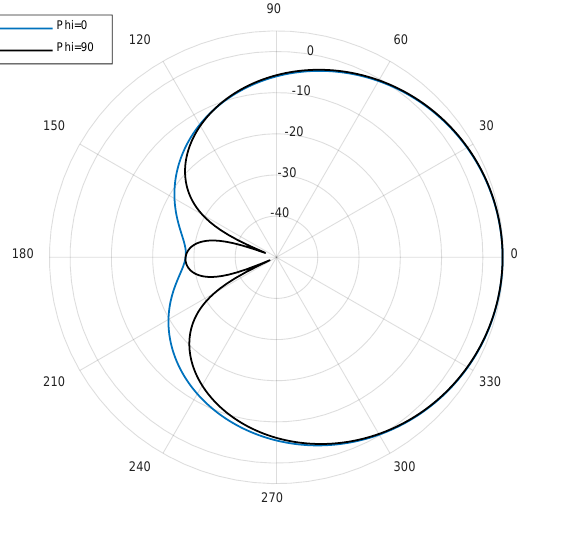
Figure 7. Simulated realized gain (dB) for two perpedicular planes at the central frequency ( a ) RHCP at 1.574 GHz; ( b ) LHCP at 2.44 GHz. The results correspond to Antenna 3.